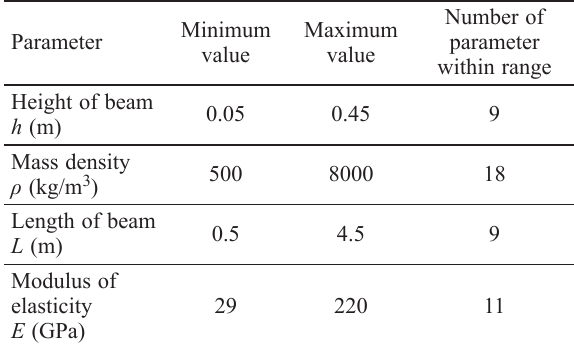
Table 1. Ranges of beam material and geometrical properties used in training the neural network Parameter